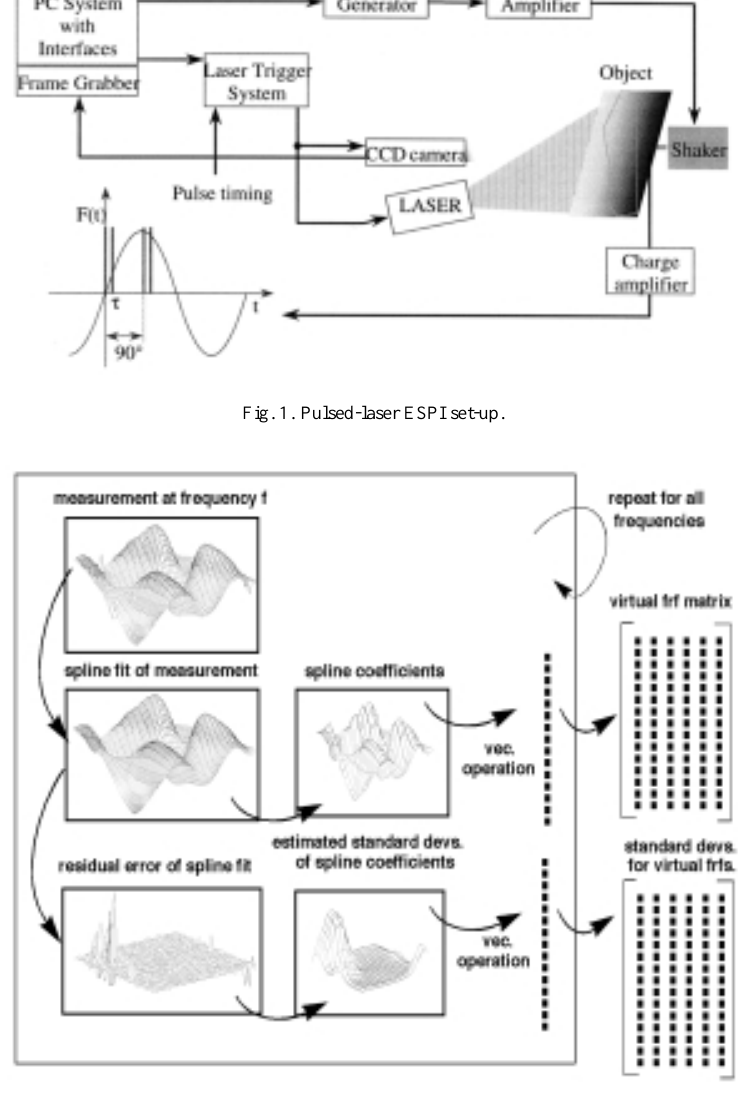
Fig. 2. Data reduction